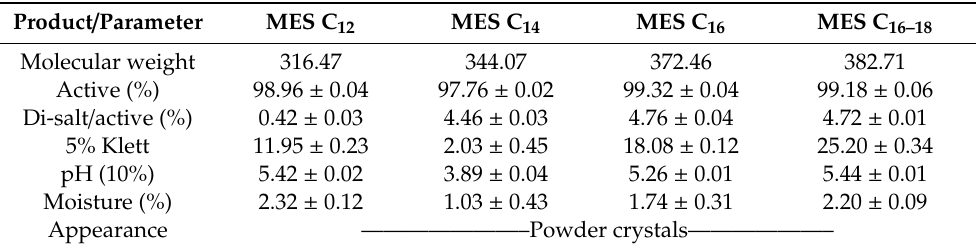
Table 1. Specifications of high active content crystallized MES powder.